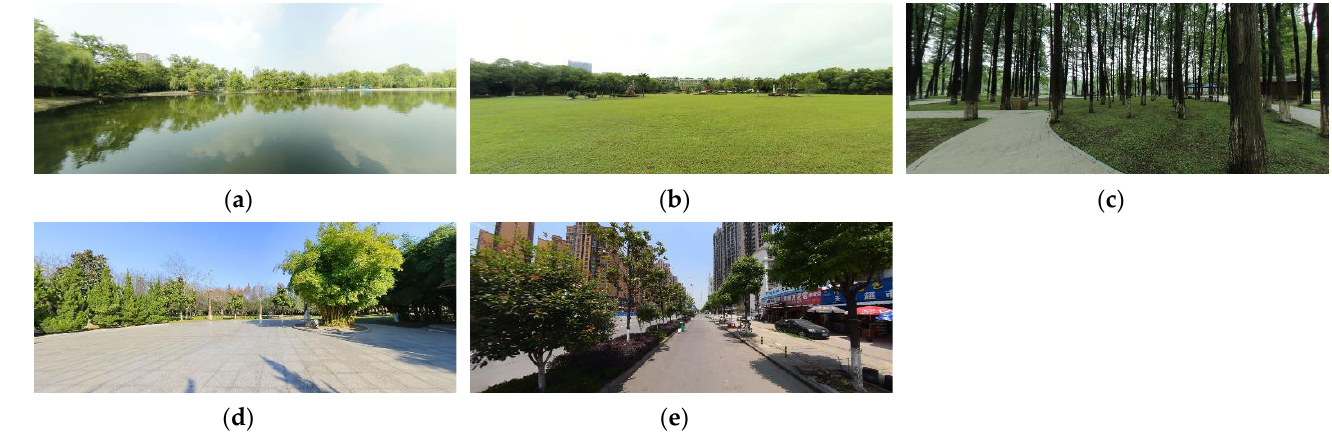
Figure 1. Example screenshots of five environment treatments: waterside ( a ), lawn ( b ), forest ( c ), plaza ( d ), and green street ( e ).